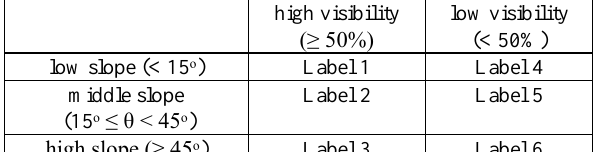
Figure 6. The slope map